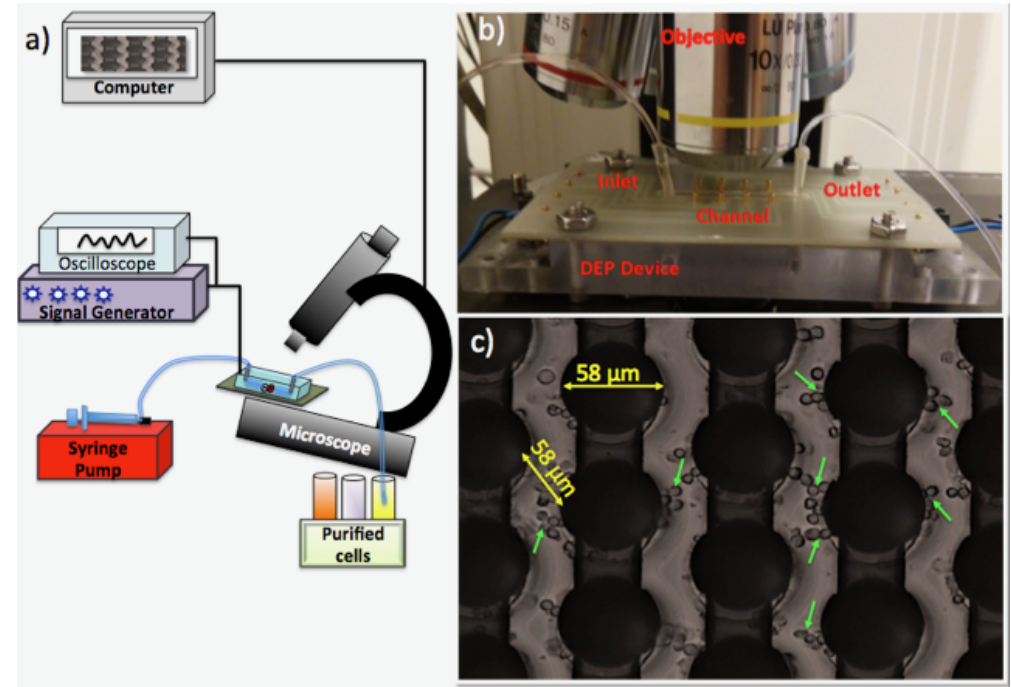
Figure 2. The experimental setup ( a ) equipment is used for the 3D carbon-Dielectrophoresis experiments include an upright microscope, an oscilloscope, a signal generator, a syringe pump and the 3D carbon-DEP chip; ( b ) the 3D carbon-DEP chip under the objectives; ( c ) the carbon-electrode array [43]. The green arrows show the